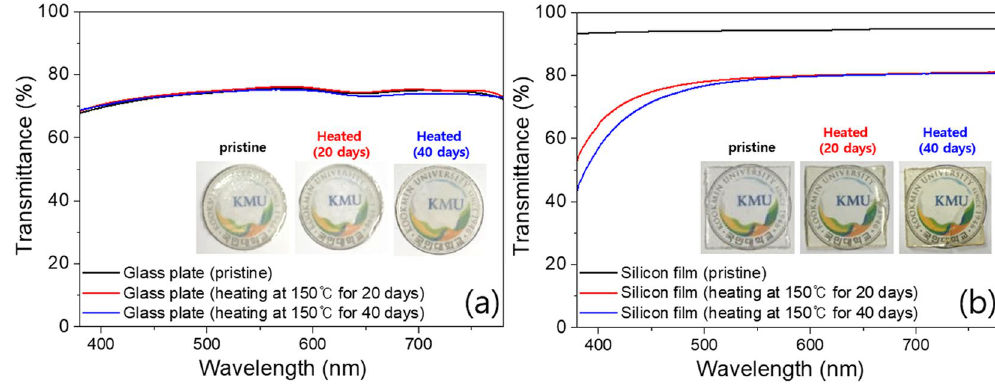
Figure 4. Optical transmittance spectra of ( a ) a bare glass plate and ( b ) cured silicone film in the pristine and heat-treated